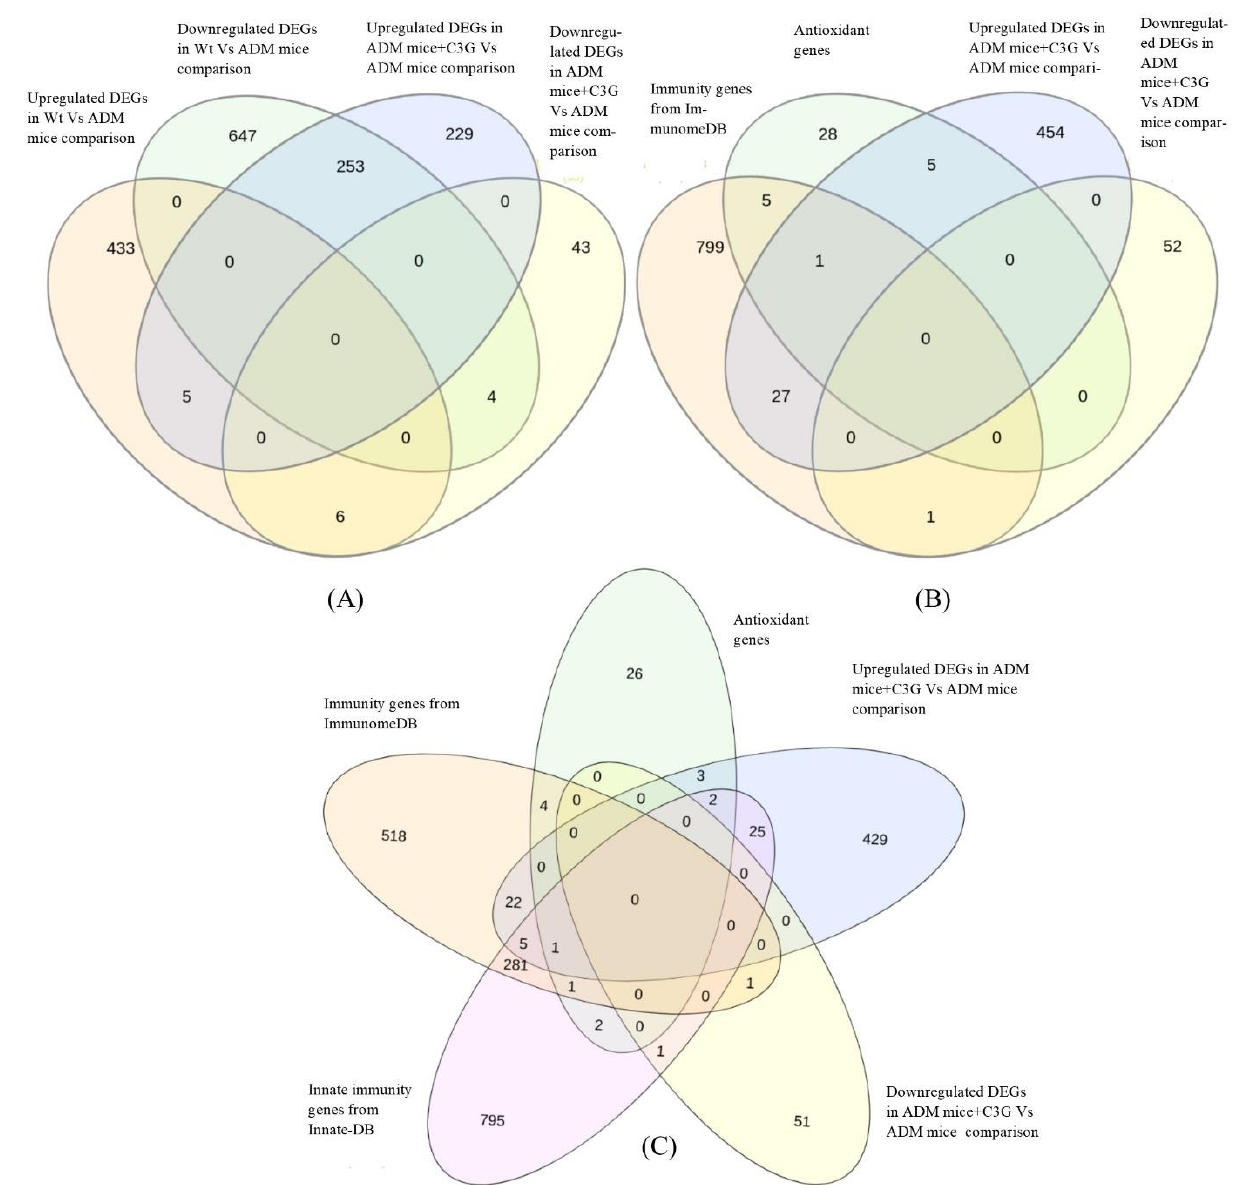
Figure 3. ( A ) Venn diagram of DEGs based on Wt mice vs. ADM mice and ADM mice+C3G vs. ADM mice comparisons. ( B ) Venn diagram of DEGs (Wt mice vs. ADM mice) overlapping with immunome database and genes associated with innate immunity from InnateDB. ( C ) Venn diagram between DEGs (ADM mice+C3G vs. ADM mice) with antioxidant, immunome database, and innate immune-related genes.